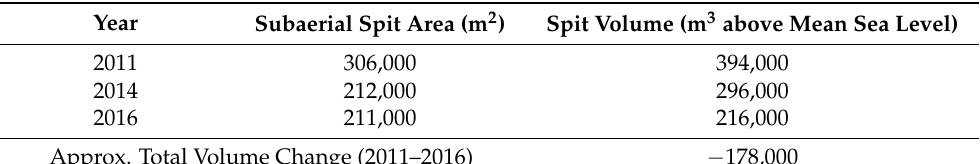
Table 1. Area and volumes of Southern Spit (eastern end, Castle Neck), 2011–2016 (based on NOAA Digital Coast data viewer using USGS and USGS CoNED project